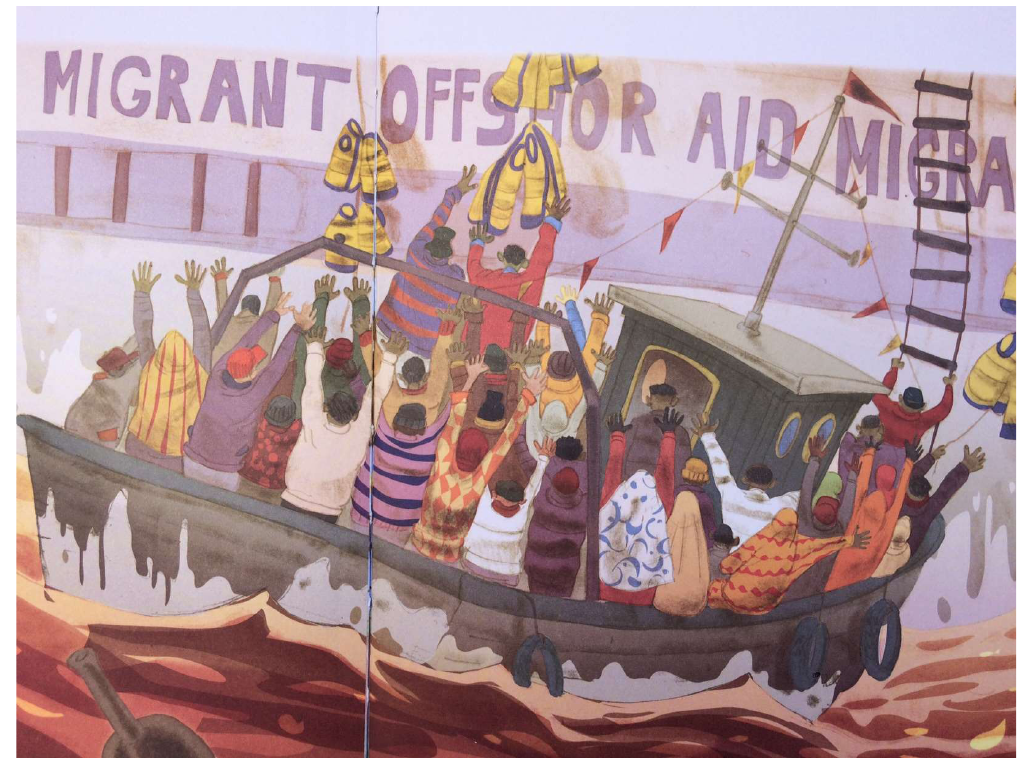
Figure 7. Rescue of refugees, by: L’immigrazione spiegata ai bambini , cit. p.